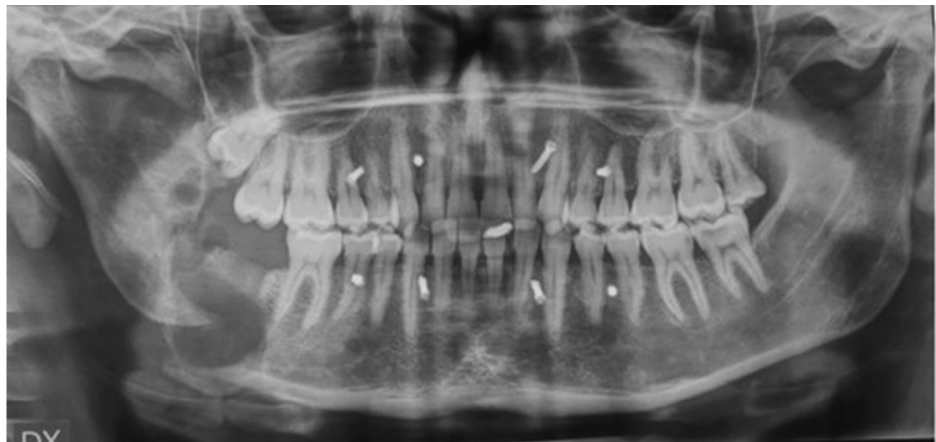
Figure 9. Pre-surgery panoramic X-ray showing a wide radiolucent lesion involving the body and ramus of the right mandible.